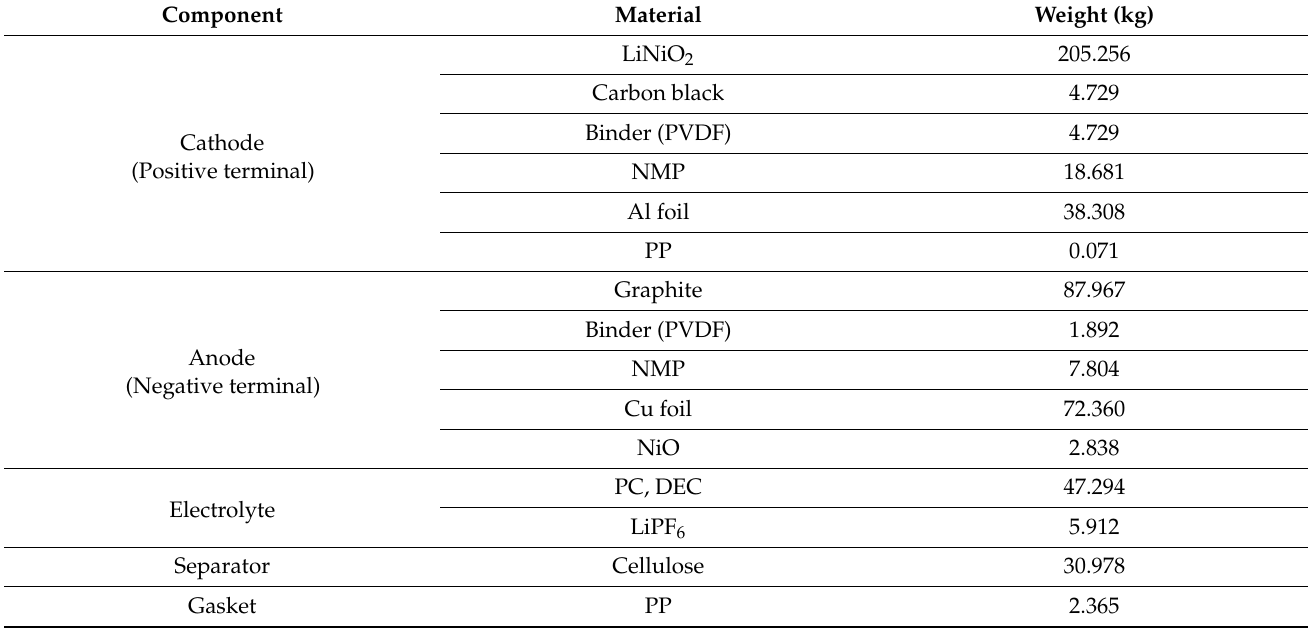
Table 2. Unit components of generic data